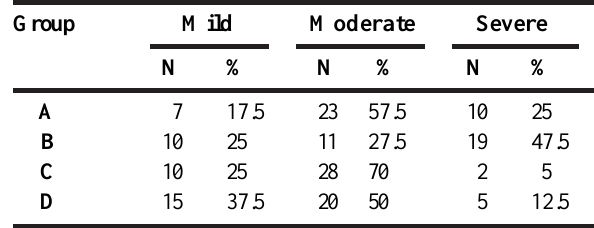
TABLE 2 - Histopathological evaluation of surgical wound.